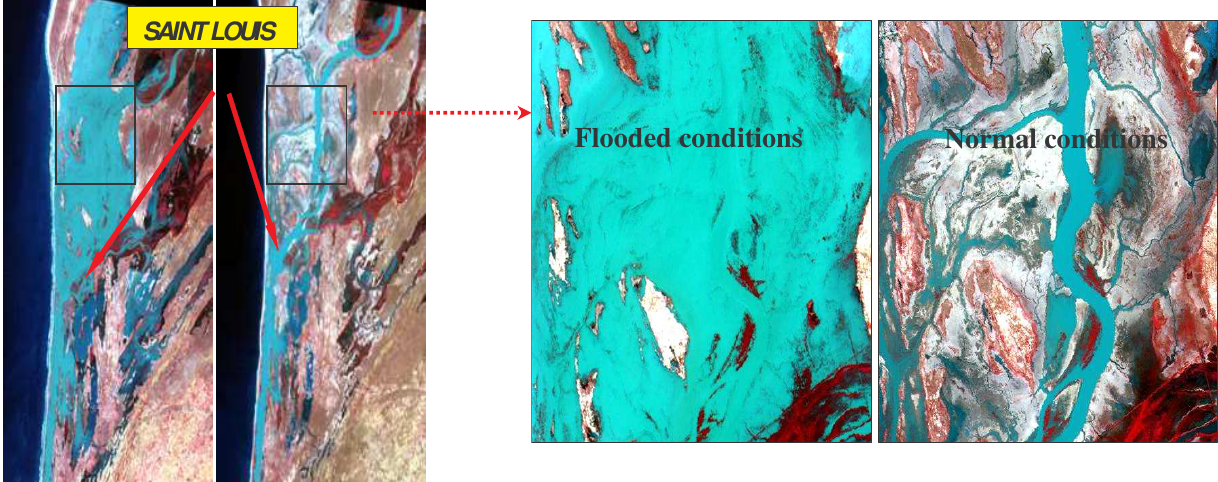
Figure 4: Satellite Imagery of Senegal River Lower Estuary, Flood conditions in October 1999 (left) and no flood conditions in October 2001 (right) The impacts of the floods were severe because of the high levels of vulnerability and low levels of resilience of the population, the lack of adequate physical protection infrastructure and changing flood patterns due to environmental change as well as the impact of the Diama dam’s structures. Man-made factors contributed to the seriousness of the event. The increasing occupation of floodplains around the city of Saint Louis in the estuary, competing and conflicting developmental demands in the lower Senegal river valley have exacerbated the impacts of floods on society (Dia, 2004). Even though the floods are obviously a fact of nature, their impacts on local resident depend on a large scale on the behaviour of the